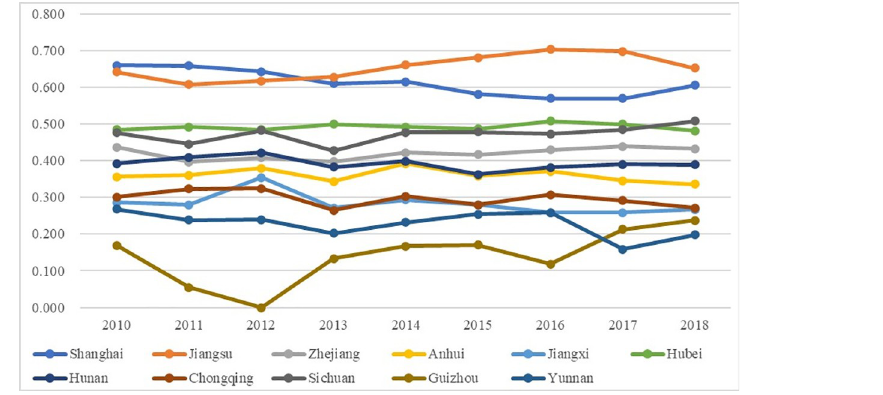
Fig 5. Overall performance of the higher education system.